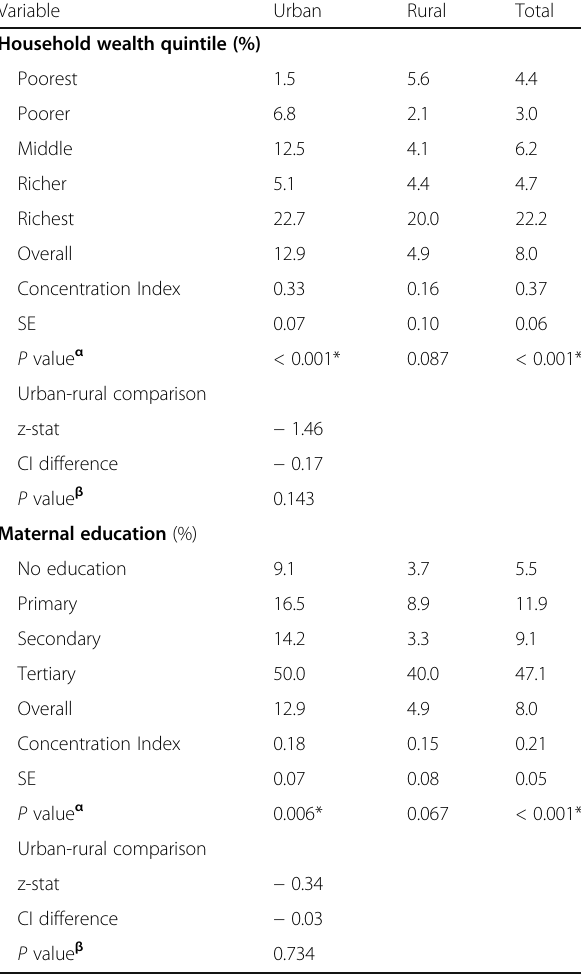
Table 4 Prevalence and Concentration Index of ≥ 8 ANC contacts by household wealth quintile and maternal education, BDHS,